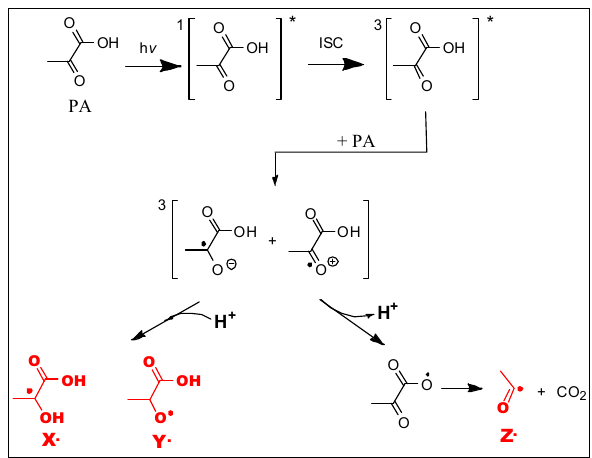
Scheme A. Initiation steps of the pyruvic acid oligomerization mechanism, after Guzman et al. (2006b, 2007) and Rincon et al. (2009, 2010). See text for details.